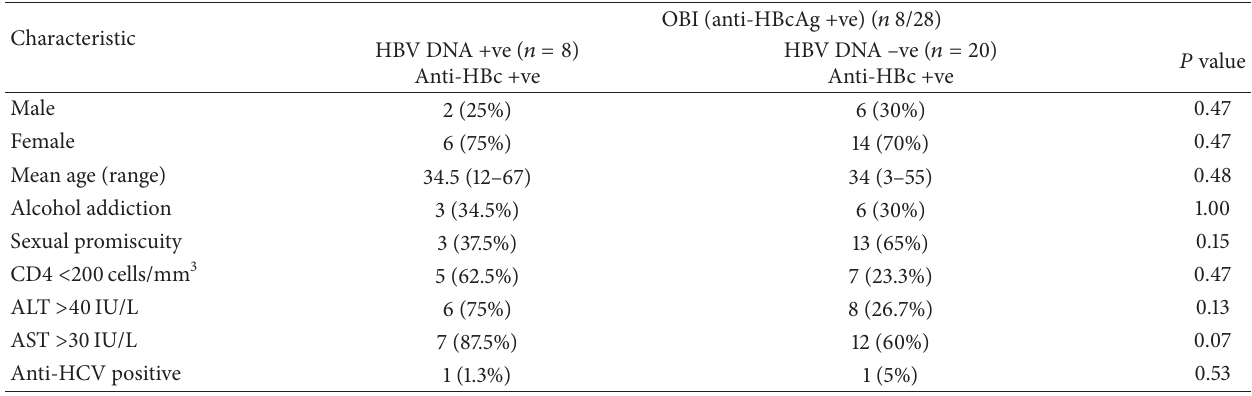
Table 2: Evaluation of overall demographic, biochemical, and virological parameters of anti-HBc positive samples. 𝑃 values calculated by Fisher test and 𝑡 -test.